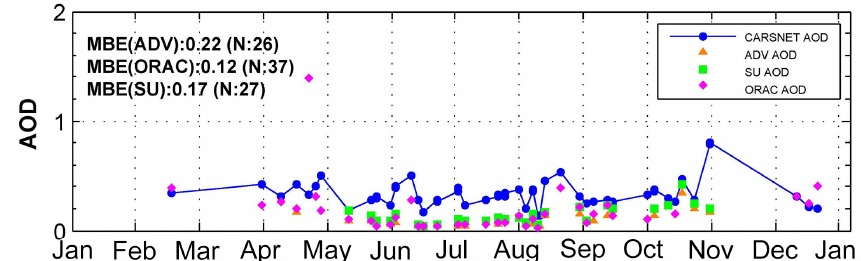
Figure 10. Time series comparison of AATSR AOD with CARSNET AOD at Urumchi in 2008.